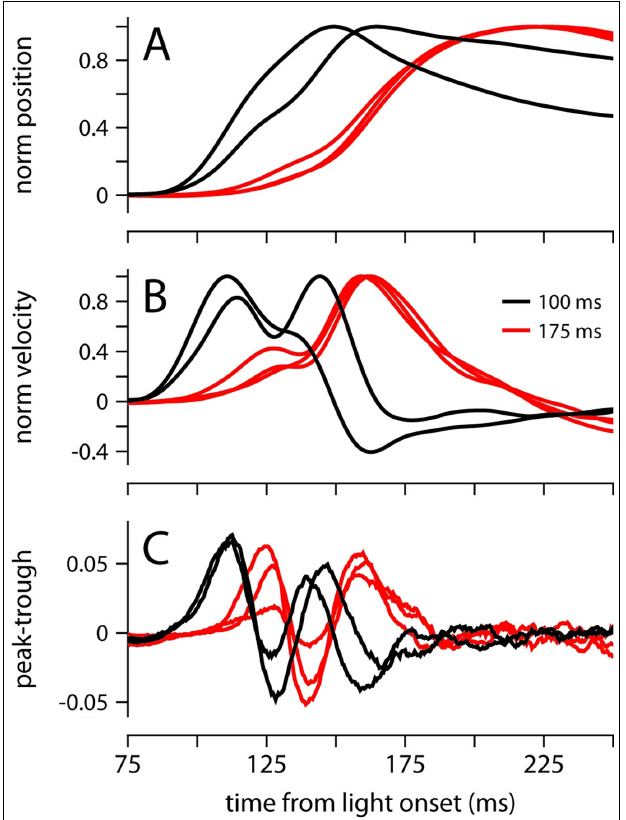
FIGURE 6 | Conditioned eyelid movements with a 100-ms ISI. (A) Normalized average eyelid position, and (B) normalized average velocity for mice trained with a 100-ms (black) or 175ms ISI (red). (C) Difference between the probability of finding a peak and a trough at each ms from light onset. Color code for all plots indicates ISI and is shown in (B)